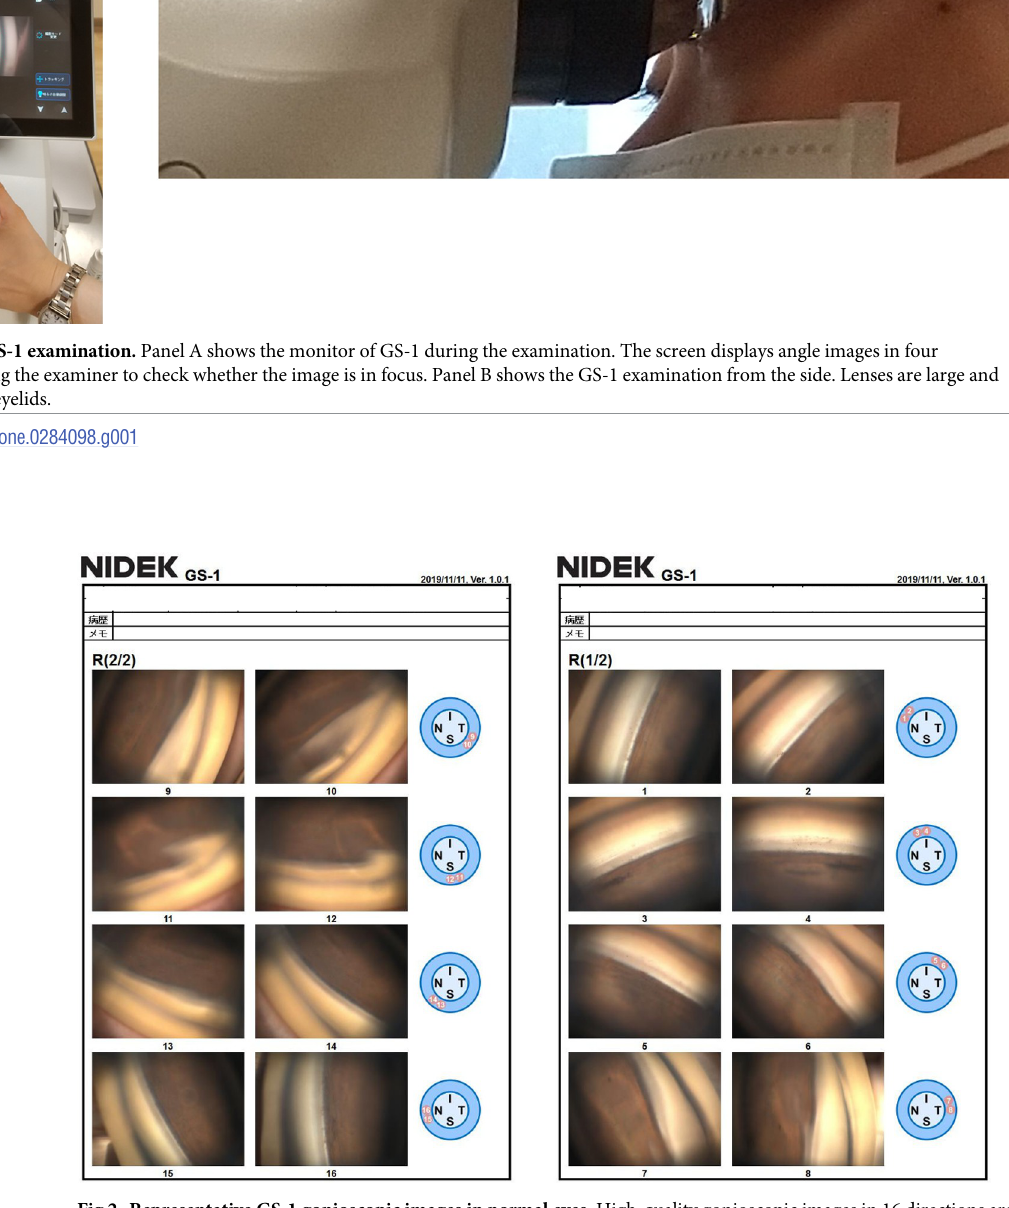
PLOS ONE | https://doi.org/10.1371/journal.pone.0284098 April 6,